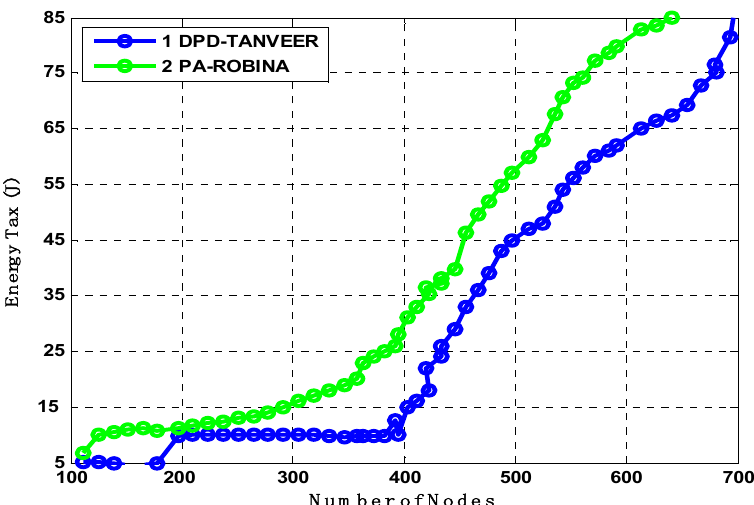
Figure 15. Analysis of energy tax compared with DPD-TANVEER and PA-ROBINA.